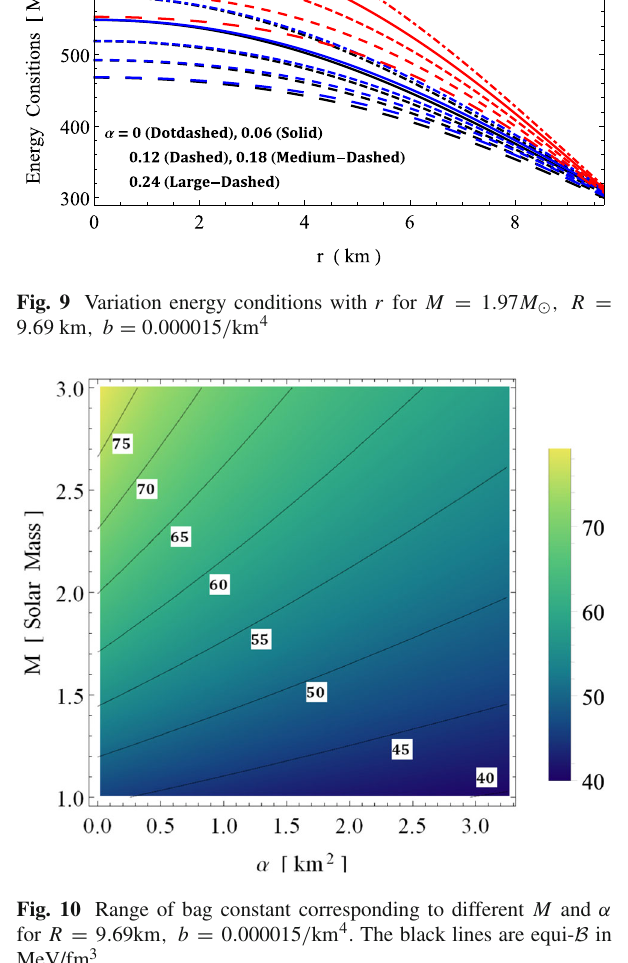
Fig. 11 Range of bag constant corresponding to different M and α for R = 12km , b = 0 . 000015 / km 4 . The black lines are equi- B in MeV / f m 3